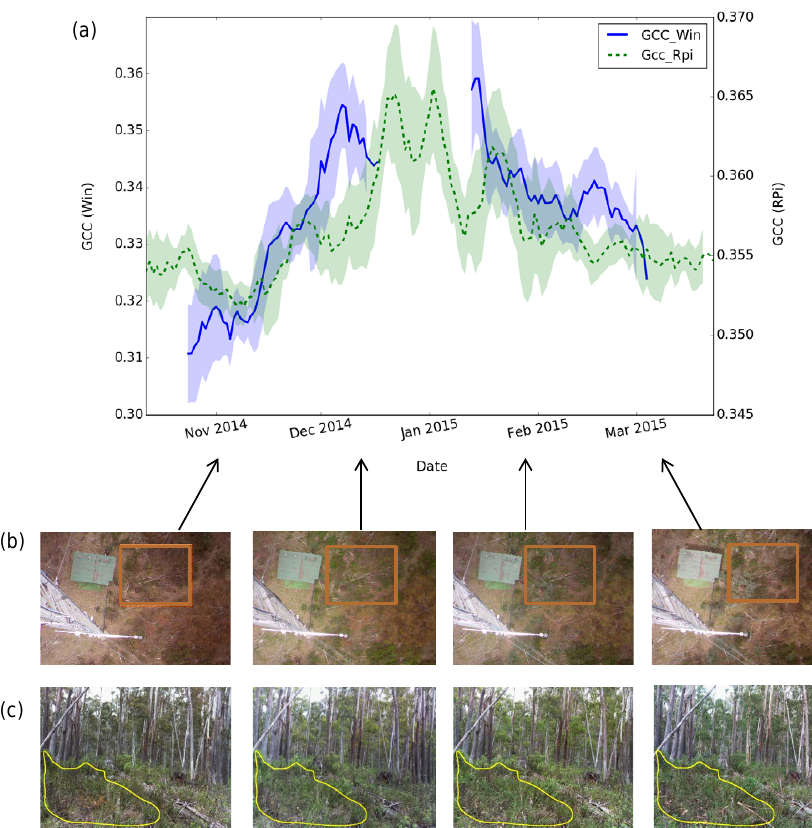
Figure 6. Phenocams in use at the Tumbarumba wet temperate OzFlux site (Fig. 2; site 3, AU-Tum), New South Wales, Australia. Panel (a) shows green chromatic coordinates (GCC) for understorey vegetation from two individual understorey phenocams; (b) shows a downward facing TimeLapseCam Wingscapes (GCC_Win) phenocam (region of interest inset) and (c) an oblique facing raspberry pi (GCC_Rpi) phenocam (region of interest inset). GCC data are shown by an 8-day centred running mean with ± 90% confidence